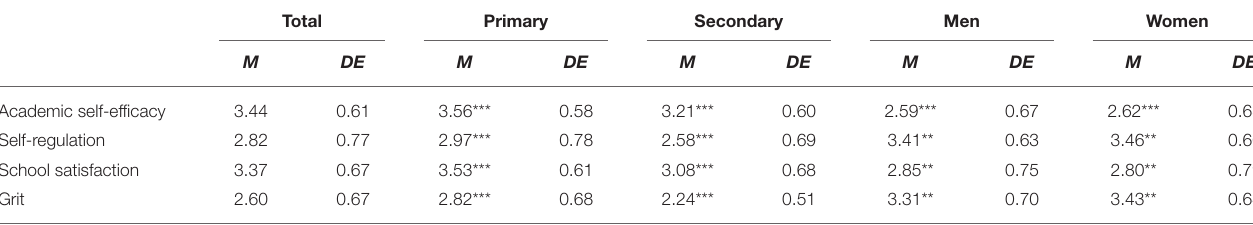
TABLE 2 | Descriptive statistics.